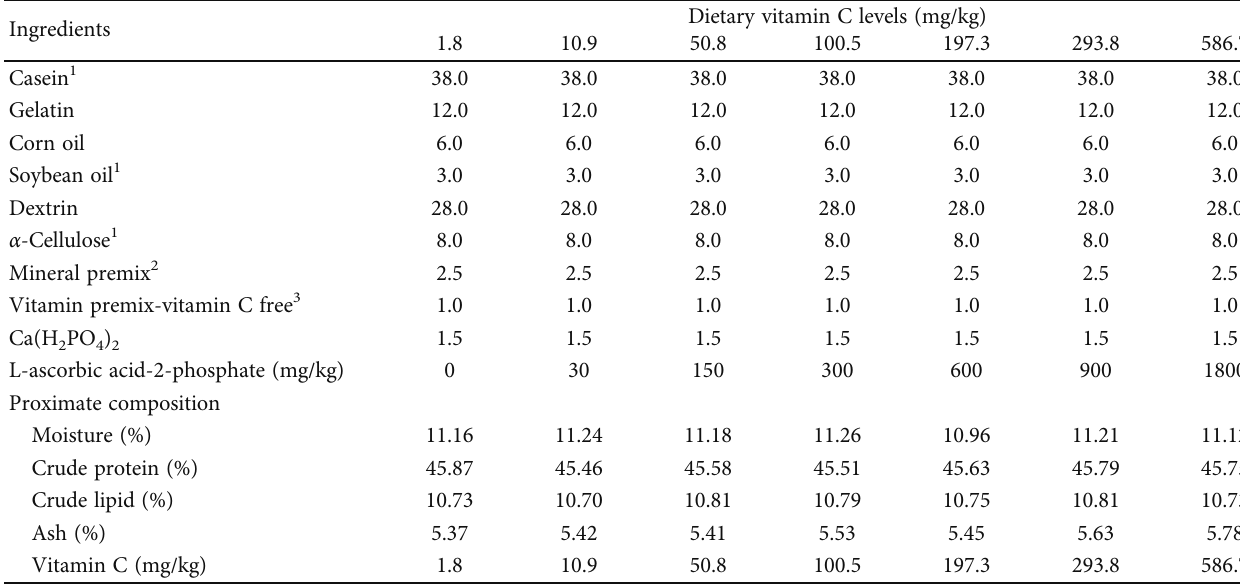
Table 1: Formulation and proximate composition of the experimental diets for coho salmon Oncorhynchus kisutch (Walbaum, 1792) postsmolts (% dry